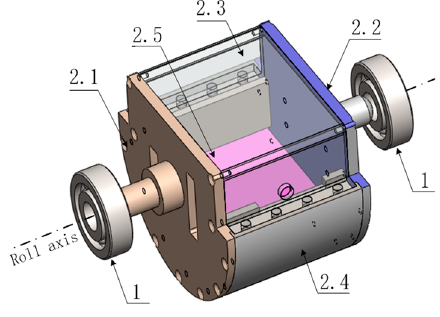
Figure 5. Composition diagram of the newly designed SSP.